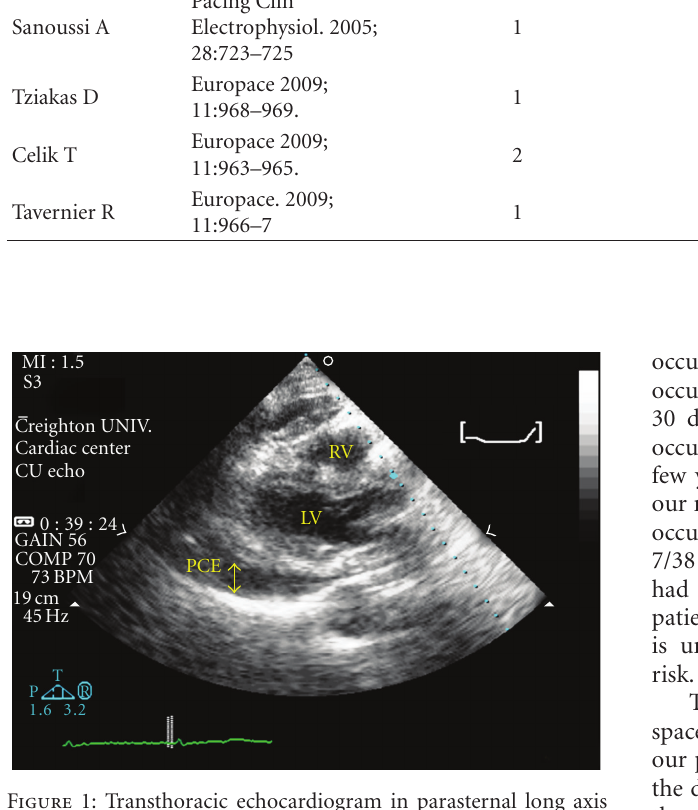
Figure 1: Transthoracic echocardiogram in parasternal long axis view showing the large pericardial e ff usion. LV: left ventricle; RV: right ventricle; PCE: pericardial e ff